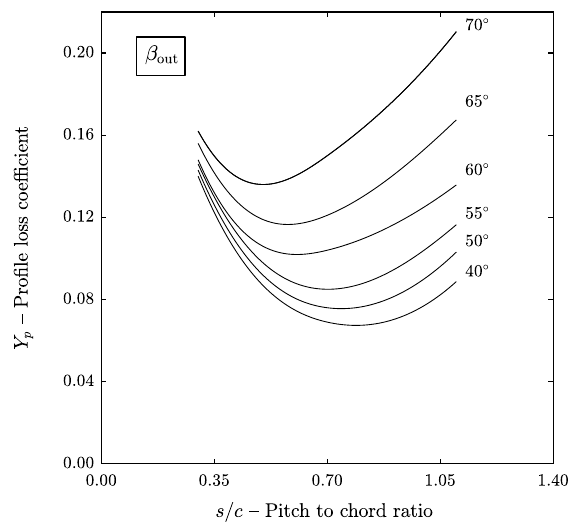
Figure A2. Profile loss of impulse